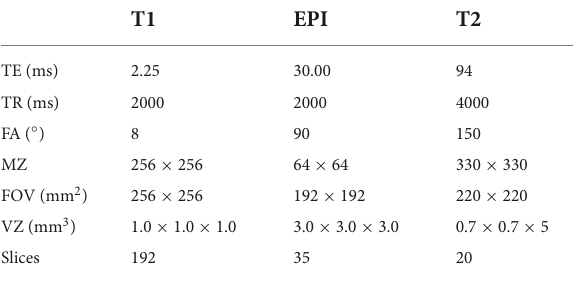
TABLE 2 MRI scan parameter